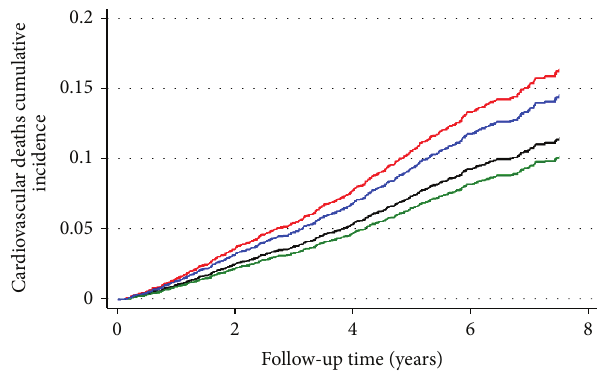
Figure 1: Cardiovascular deaths cumulative incidence functions. Green line: females exposed to glargine; black line: females unex- posed to glargine; blue line: males exposed to glargine; red line: males unexposed to